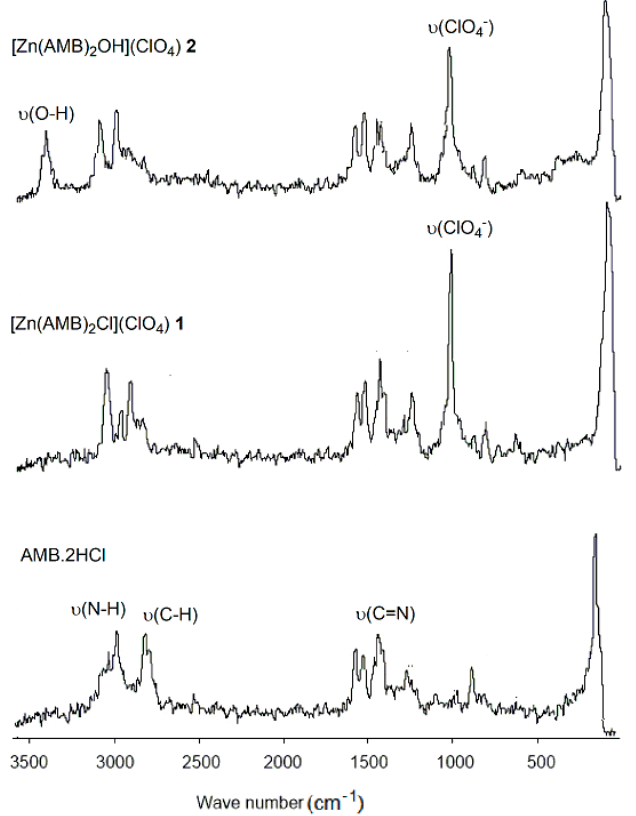
Figure 3. Raman spectra of the ligand AMB ∙ 2HCl and its zinc(II) model complexes [Zn(AMB) 2 Cl](ClO 4 ) 1 and [Zn(AMB) 2 (OH)](ClO 4 ) 2 .